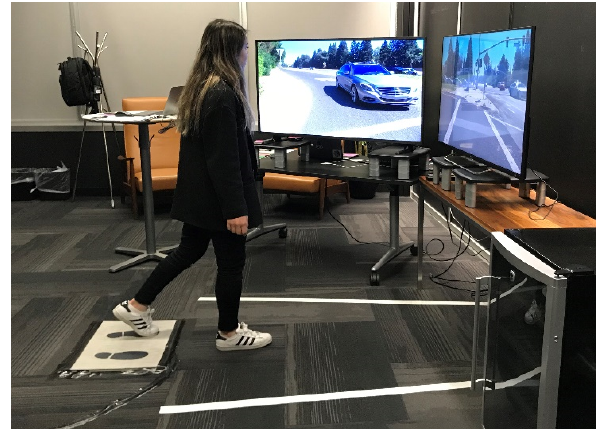
Figure 4. Study setup. Reproduced with permission from Faas, Kao and Baumann, A